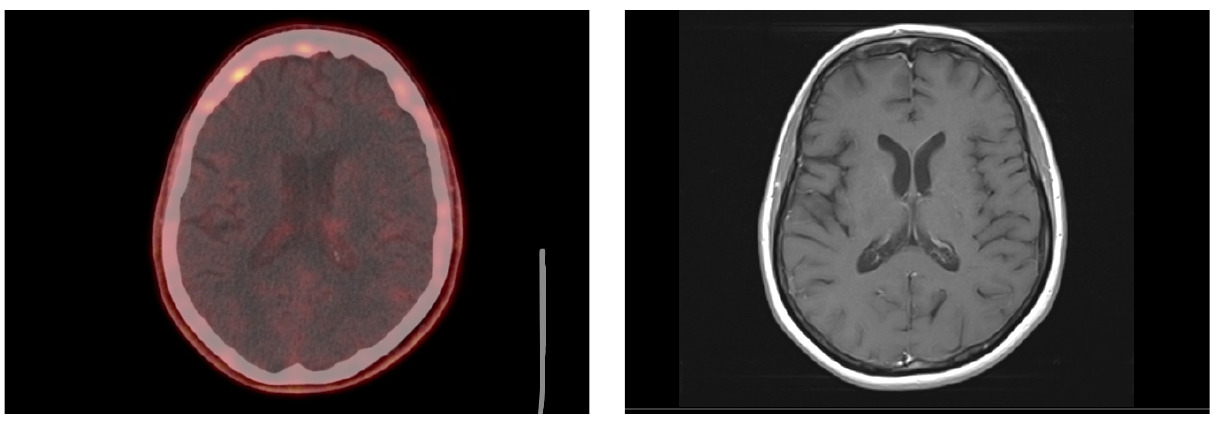
Fig. 1d. Axial T1-weighted MRI scan showing effacement of the contrast-enhanced lesion in the right periventricular region.